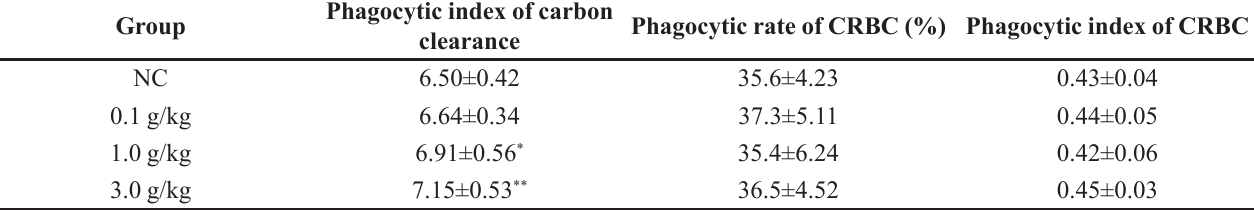
TABLE III - Effects of OR on the carbon clearance function of mononuclear macrophages and peritoneal macrophages phagocytosing CRBC in mice